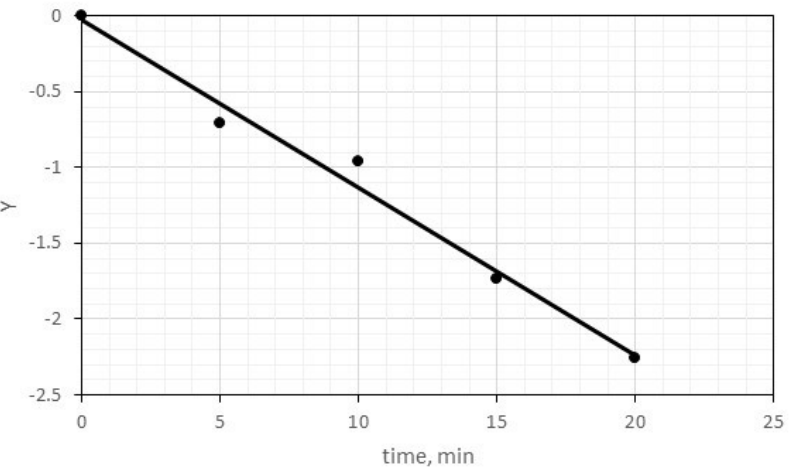
Figure 7. Langmuir kinetics for the photocatalytic oxidation of 2-methyl-4-chlorophenoxyacetic acid (MCPA) (experimental data deduced from [20]).